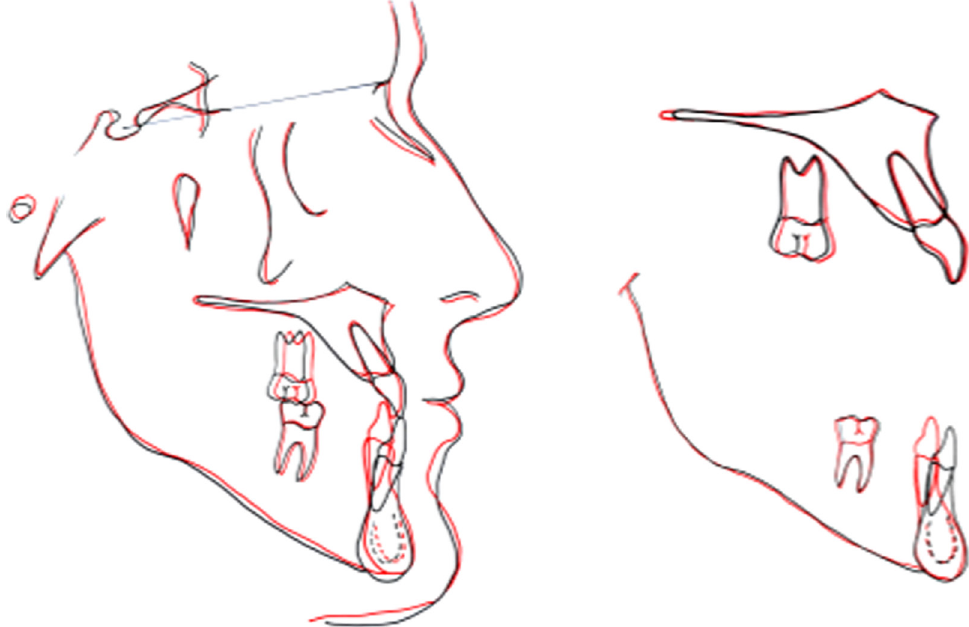
Figure 5. Superimposition of initial and final tracings at SN, maxilla and mandible, respectively.